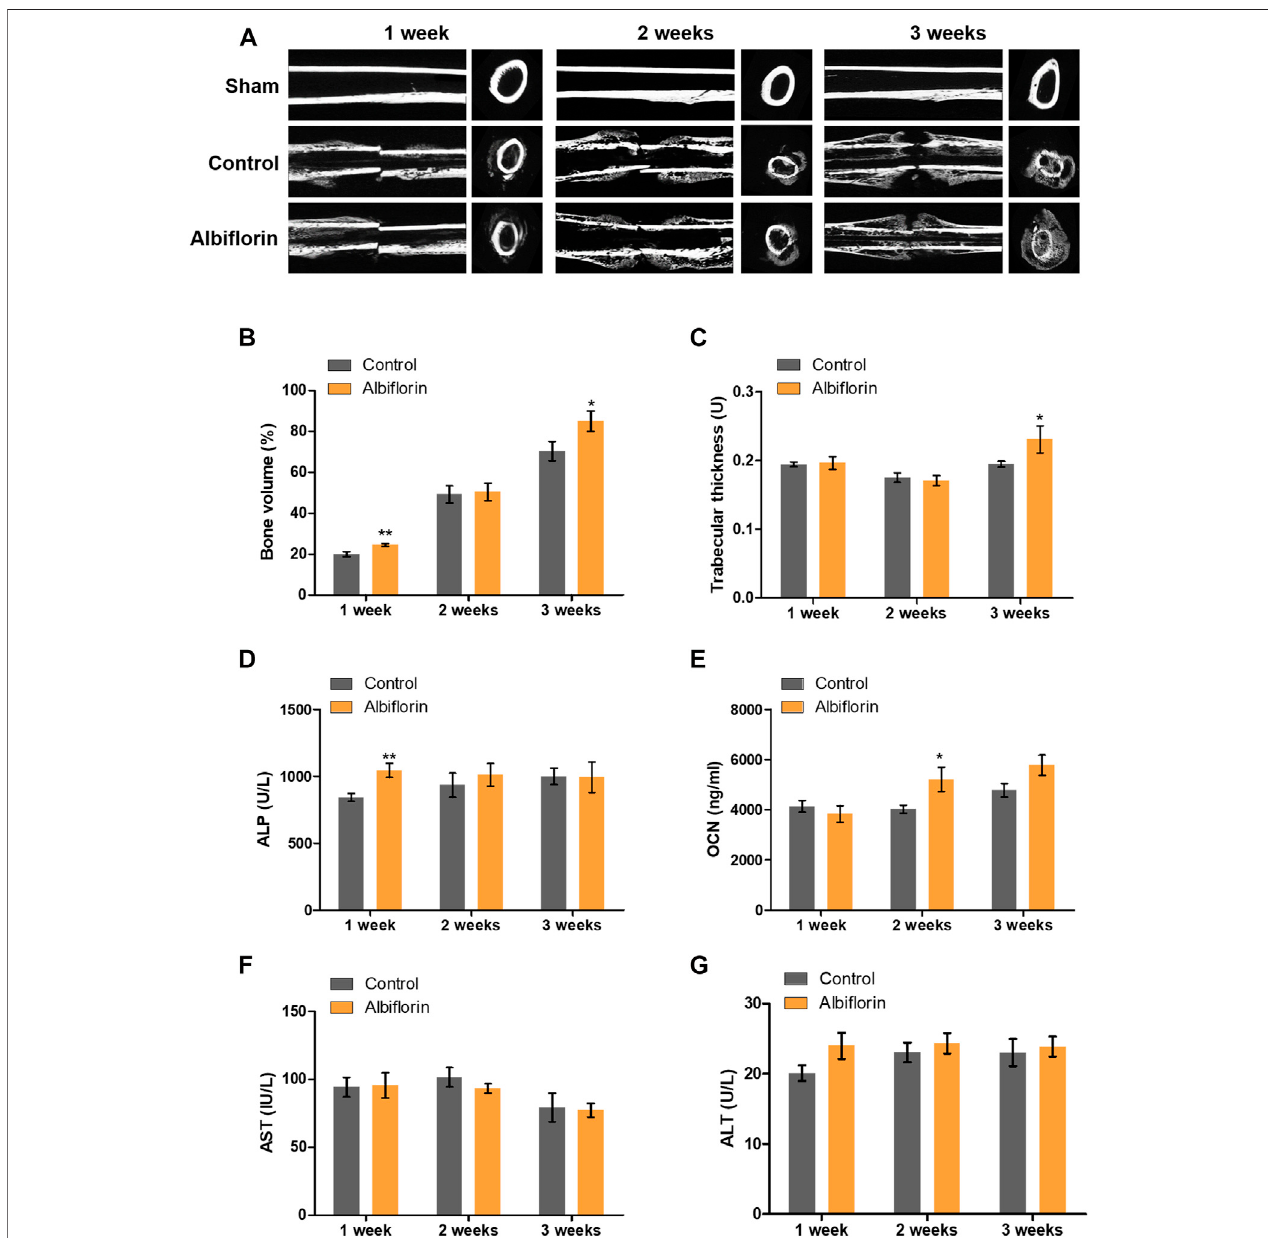
FIGURE9| Effectofalbi fl orinonhealingofratfemoralfractures (A) Sagittalplaneand(leftpanel)axisplane(rightpanel)micro-CTimageofafracture-inducedfemur at1,2and3 weeks (B) Bonevolumeand (C) trabecularthicknesswereanalyzedbymicro-CTExpressionof (D) ALP, (E) OCN, (F) ASTand (G) ALTwasmeasuredusing ELISA in serum. These results are presented as the mean ± SEM ( n (cid:2) 6 for each group). *p < 0.05, ** p < 0.01 vs. Control.